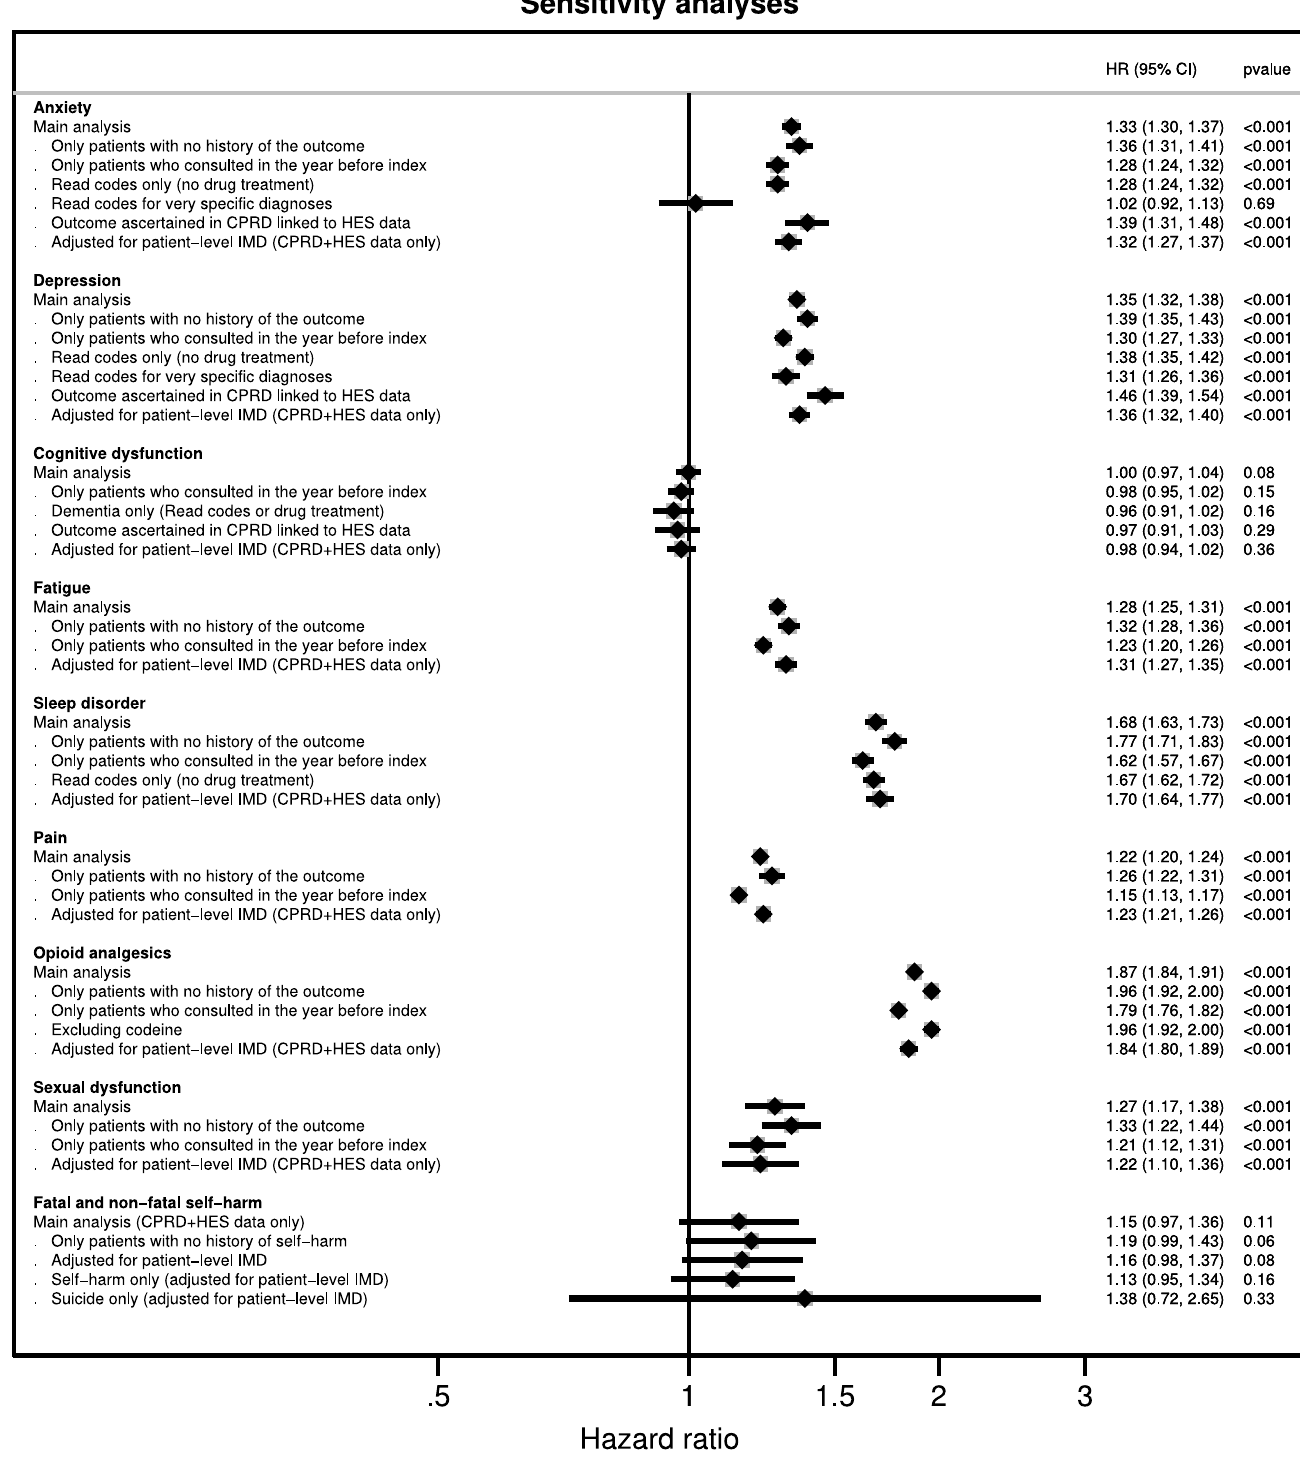
PLOS Medicine| https://doi.org/10.1371/journal.pmed.1003504 January 7,